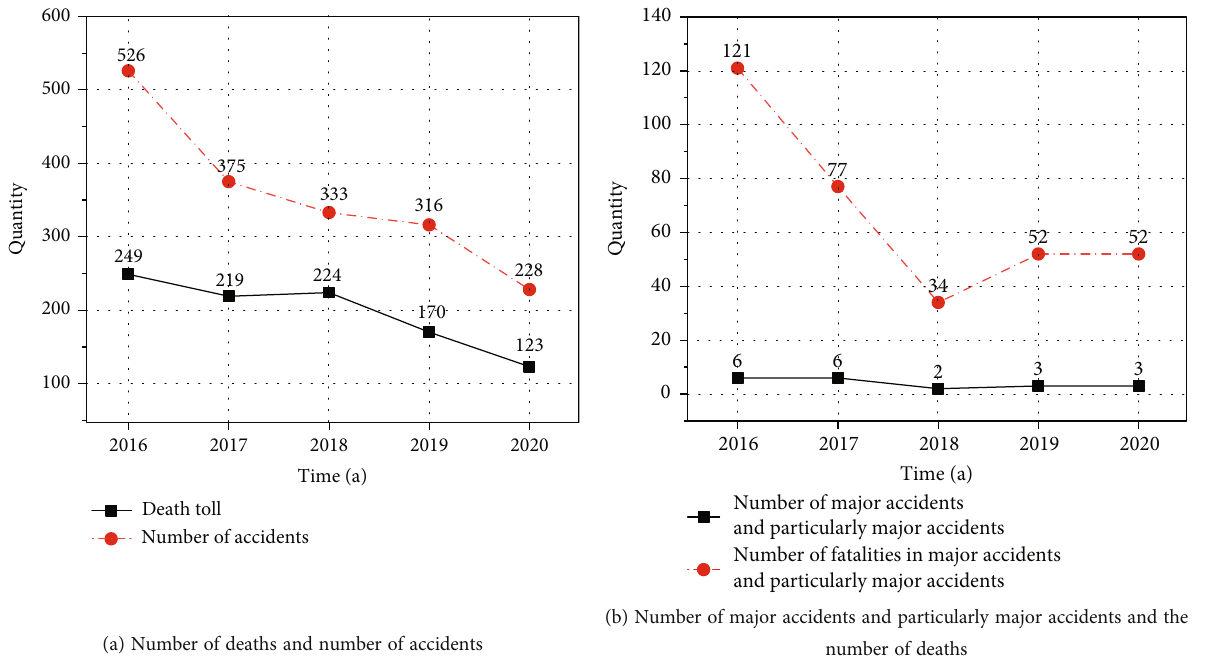
Figure 1: Coal mine accident statistical diagram for 2016-2020.